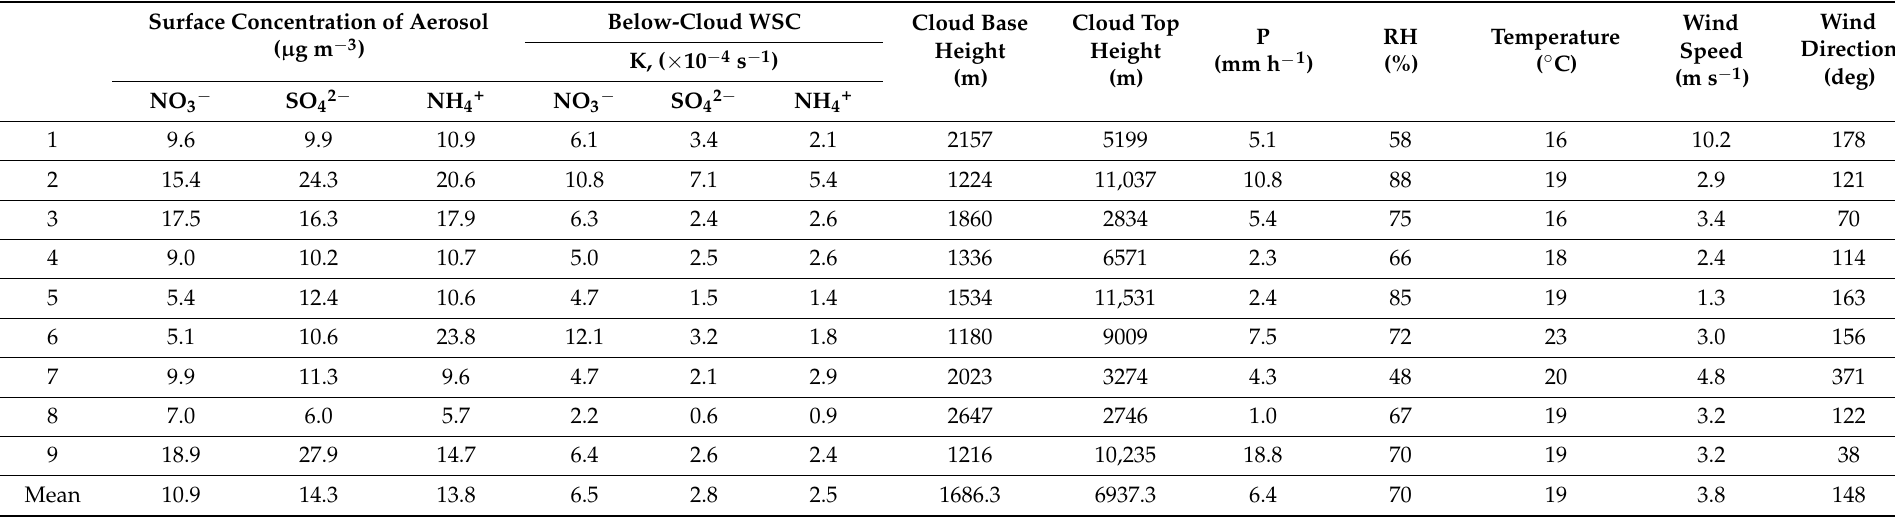
Table 1. Simulation conditions in the nine observed cases. Surface concentrations of secondary inorganic aerosols (SIAs) for initial and boundary conditions, below-cloud scavenging coefficient, cloud base height, and precipitation intensity are obtained from Xu et al. [25]. Cloud top height, relative humidity, wind speed, and wind direction are from Modern-Era Retrospective Analysis for Research and Applications, Version 2